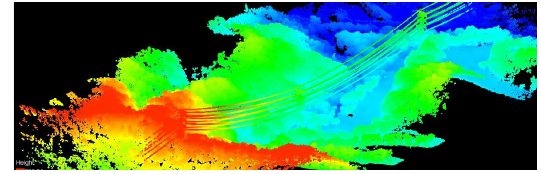
Figure 3. The cloud model of Transmission line point